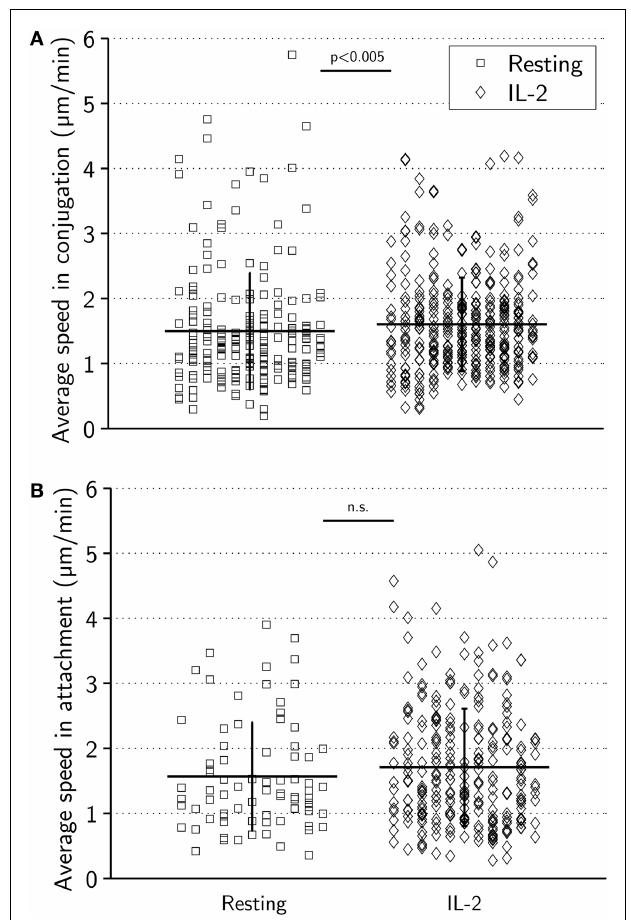
FIGURE 4 |Average speeds during target-cell contact are similar for resting and activated NK cells . (A) Average speed in conjugation for resting (left) and activated (right) NK cells. Mean ± SD was 1.5 ± 0.9 µ m/min for resting and 1.6 ± 0.7 µ m/min for activated cells. (B) Average speed in attachment for resting (squares, left) and activated (diamonds, right) NK cells. Mean ± SD was 1.6 ± 0.8 µ m/min for resting and 1.7 ± 0.9 µ m/min for activated